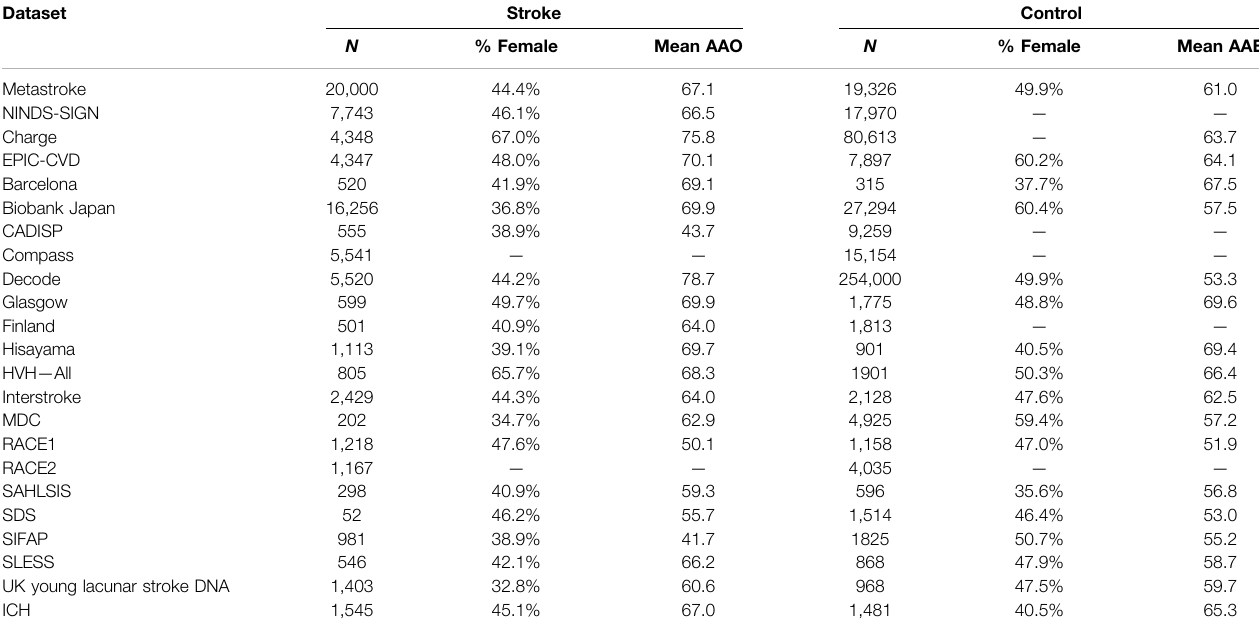
TABLE 1 | The data set and basic information of the stroke GWAS in 2018. Dataset Stroke Control